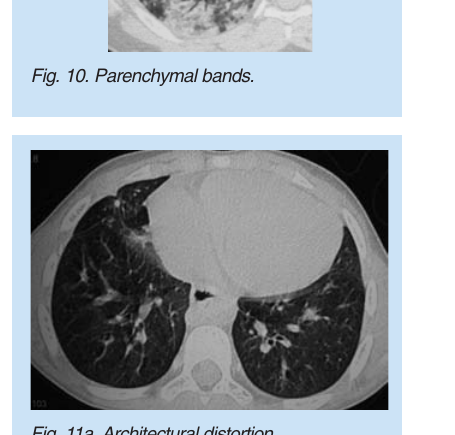
Fig. 11b. Honeycombing.